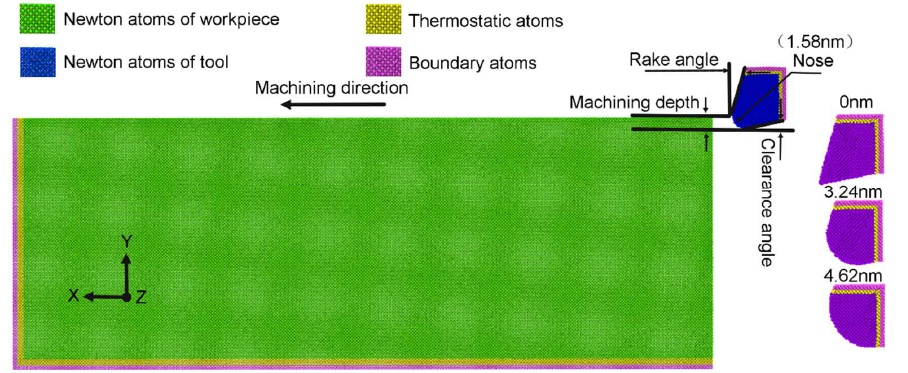
Figure 1. The nanomachining model of single-crystal nickel. To achieve cutting, a constant machining speed and backdraft were used in the sim- ulation. Fixed, constant temperature, and Newton layer assumptions were used for the workpiece and tool. The fixed layer supported the entire workpiece and prevented it from moving during friction [27]. The y ellow atom between the fixed layer and the substrate was the constant temperature layer, which adopted the Berendsen thermal bath method [28]. The temperature was maintained at 300 K by periodically adjusting the atomic ve- locity to keep the temperature at approximately ambient temperature. The blue and green atoms represent Newton layer atoms. The key research objective was to observe the pro- cessing deformation and damage of materials. Both the constant temperature and Newton layer motion followed Newton’s second law and were determined by the direct integra- tion of the classical Hamiltonian equations of motion using the velocity–Verlet method